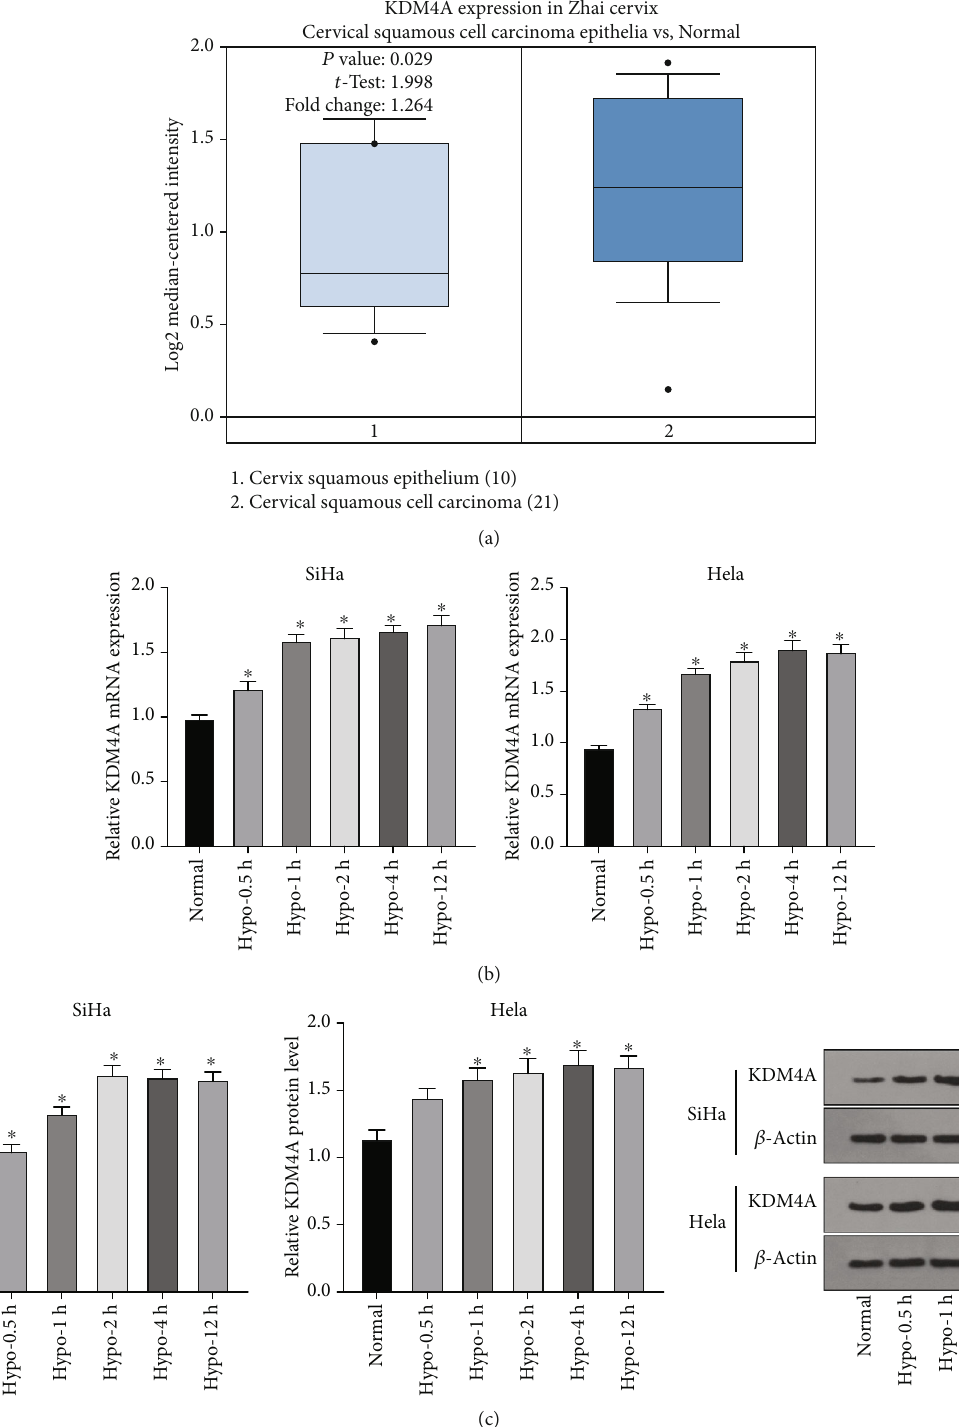
Figure 2: Hypoxia induced upregulation of KDM4A in CC cells. SiHa and Hela cell lines were treated with hypoxia for 0.5, 1, 2, 4, and 12 h. (A) The expression of KDM4A in CC research data set GSE7803 was obtained from the Oncomine database; (B-C) The mRNA and protein levels of KDM4A in CC cells were detected by RT-qPCR and Western blot. The experiments were conducted in 3 replicates independently. The data were expressed as mean ± standard deviation. One-way ANOVA was used for comparisons among groups with Tukey ’ s multiple comparisons test as the post hoc test; ∗ vs. the normal group, p <